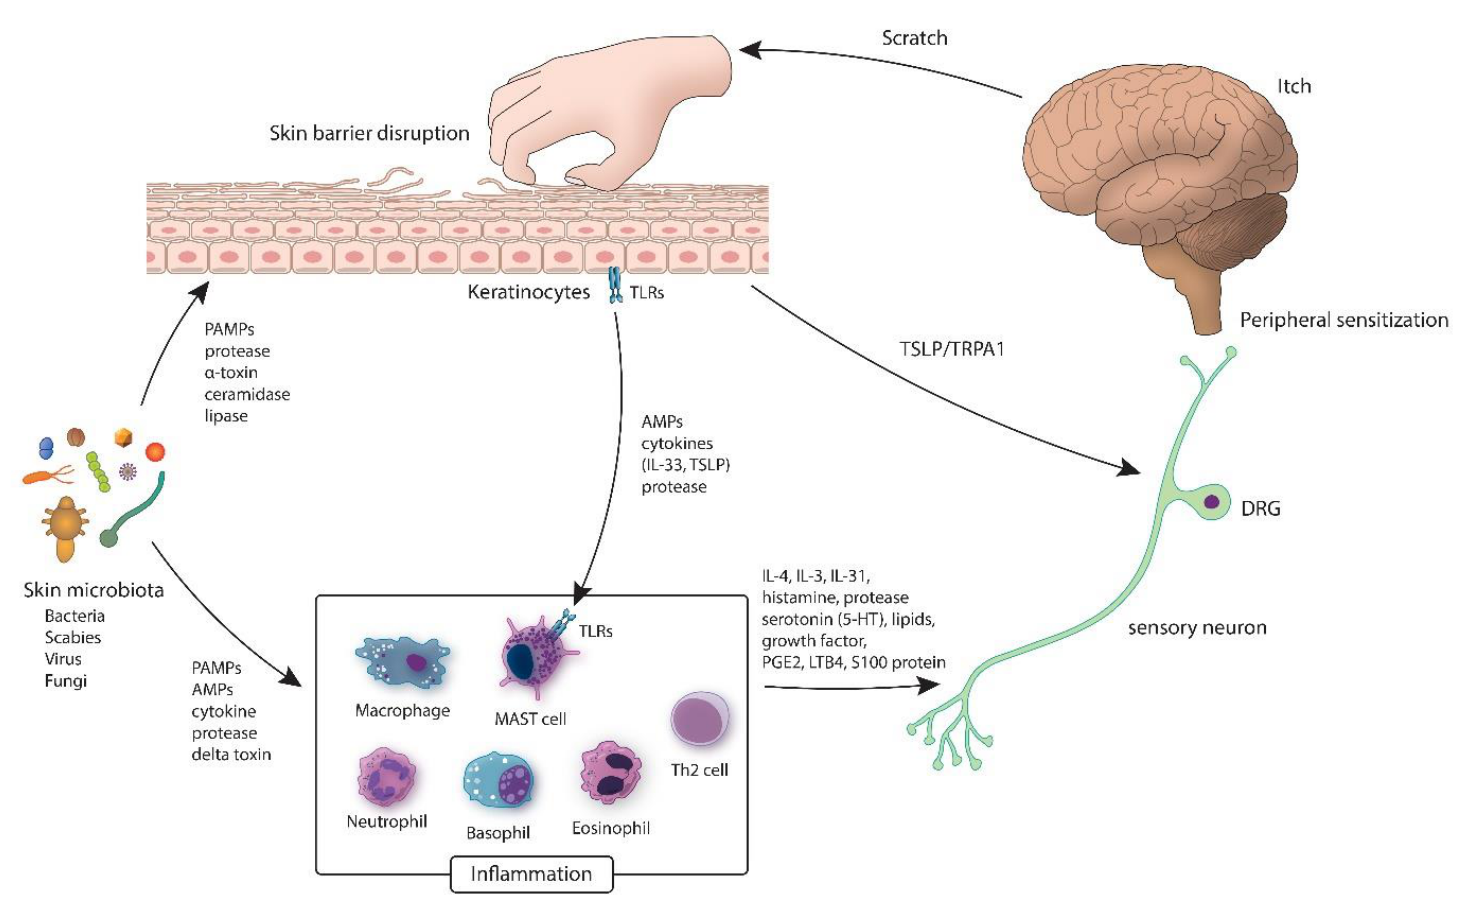
Figure 1. Inflammatory circuit of the skin microbiota. Various microbiota (bacteria, fungi and viruses) cover the exterior of a healthy skin where the barrier is intact. In the event of dysbiosis, pathogens release proteases, which may disrupt the epidermal barrier. Delta-toxin causes mast cell degranulation, which prompt inflammation and itching. AMP: antimicrobial peptides; DRG: dorsal root ganglia; IL: interleukin; LTB4: leukotriene B4; PAMP: pathogen associated molecular pattern; PGE2: prostaglandin E2; TLR: Toll-like receptor; TRPA1: transient receptor potential antigen 1; TSLP: thymic stromal lymphopoietin.